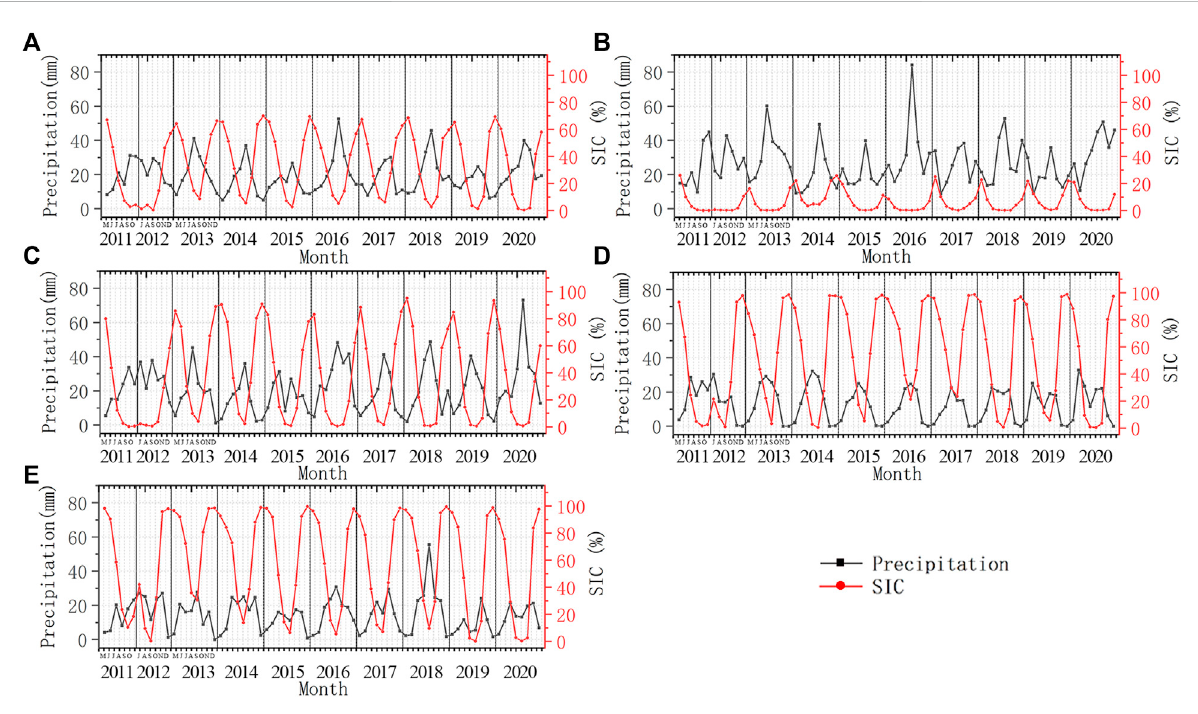
FIGURE 9 Time-seriesshowingthevariationsinmonthlyprecipitationandmonthlyaverageSICin (A) theNEP, (B) BarentsSea, (C) KaraSea, (D) LaptevSea, and (E) EastSiberian Sea for May – December for theyears 2011 – 2020. (Data for November2011,December2011,May2012,and June 2016 data are